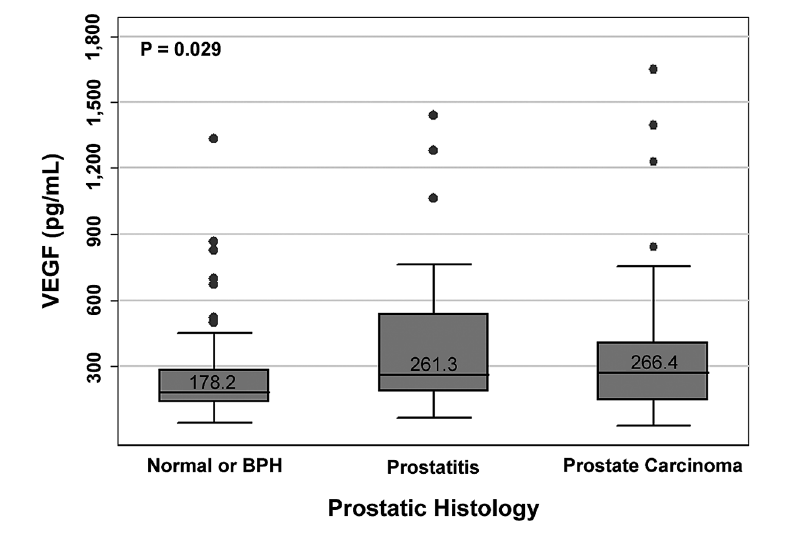
Figure 1 – Serum levels of vascular endothelial growth factor (VEGF), according to prostate biopsy histology. BPH: benign prostatic